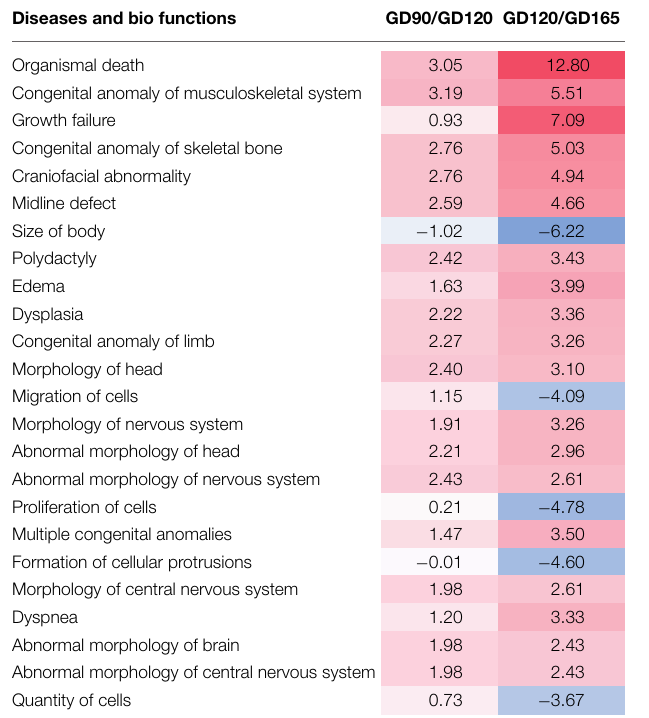
TABLE 1 | Comparison analy1sis of functional annotation for the pairwise GD90/GD120 and GD120/GD165 comparisons.